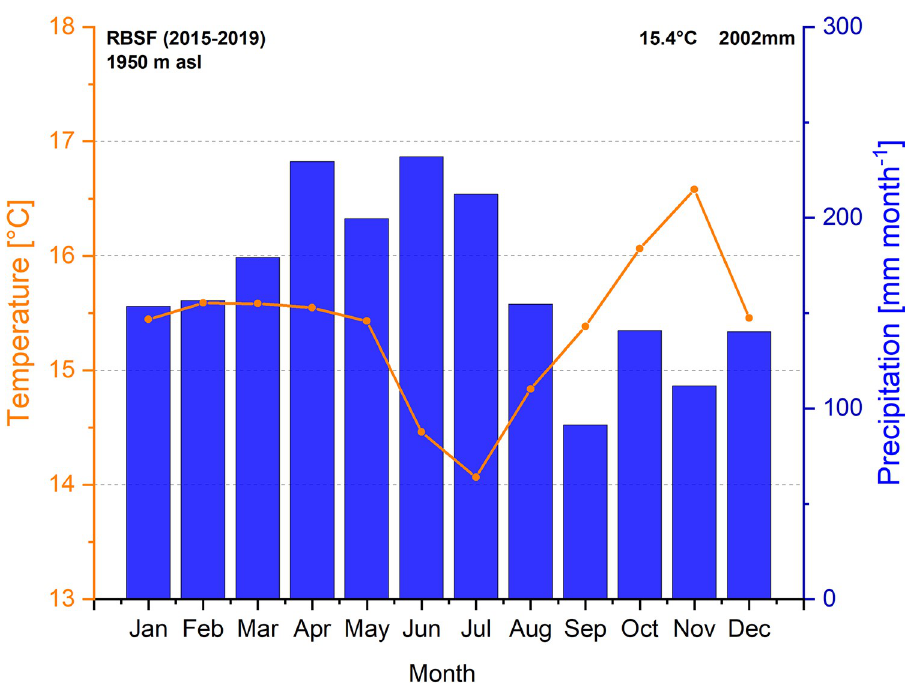
Fig 2. Climate diagram of the Reserva Biolo´gica San Francisco (RBSF) during the study period (2015–2019, 1950 m a.s.l.).